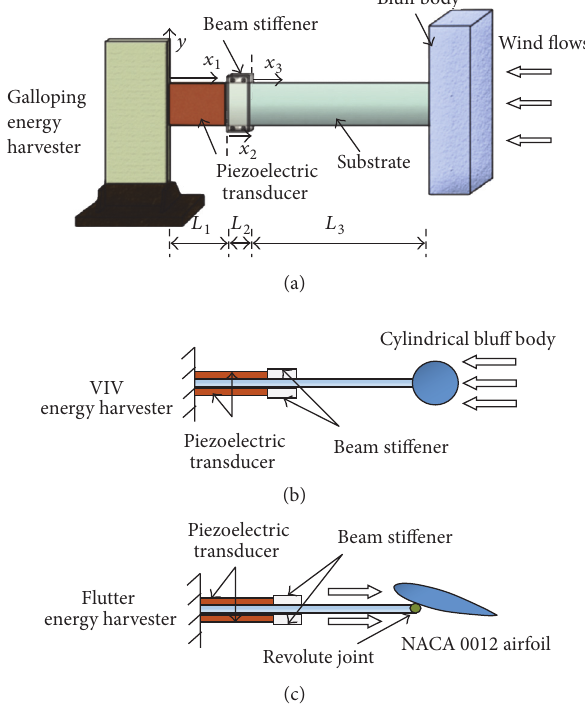
Figure 4: Configurations of enhanced energy harvesters with the beam stiffer, based on, from (a) to (c), galloping, VIV, and airfoil flutter